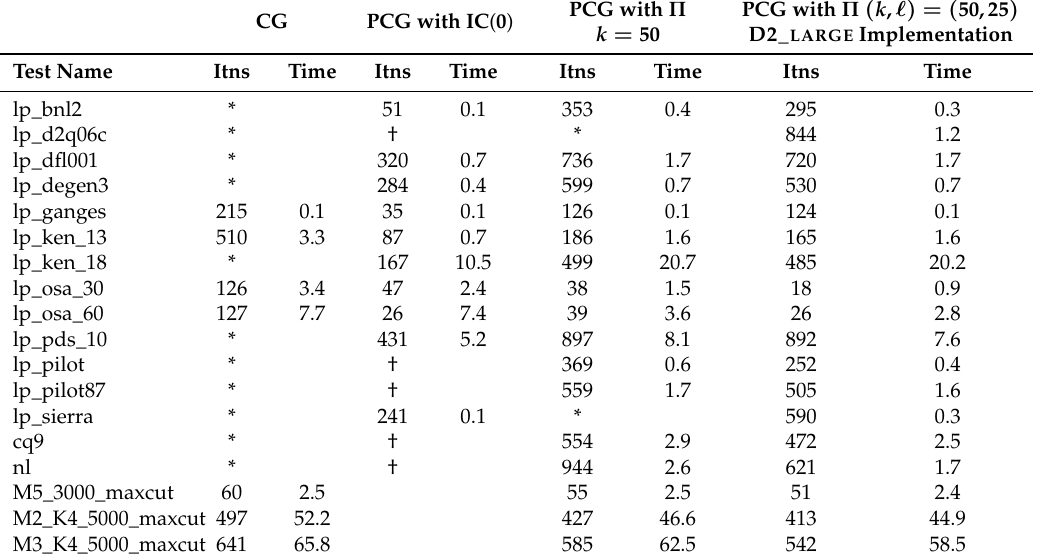
Table 3. Solution of systems with H = A Θ A T : unpreconditioned CG, CG coupled with IC(0), CG coupled with Coordinate-LMP Equation (12) k = 50, CG coupled with Coordinate-LMP Equation (16) ( k , (cid:96) ) = ( 50,25 ) and D2_ LARGE implementation. Number of PCG iterations (Itns), execution time in seconds (Time) for building the preconditioner and for PCG.